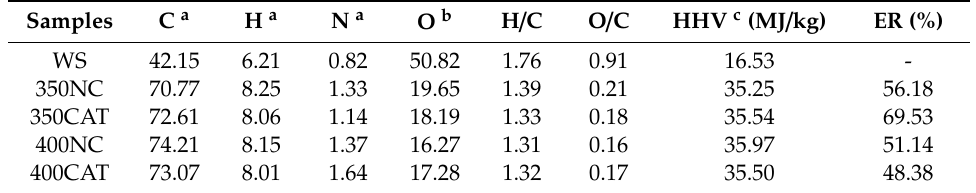
Table 2. Elemental composition, HHVs, atomic ratios, and energy recovery of biomass and HTL biocrude obtained at di ff erent process